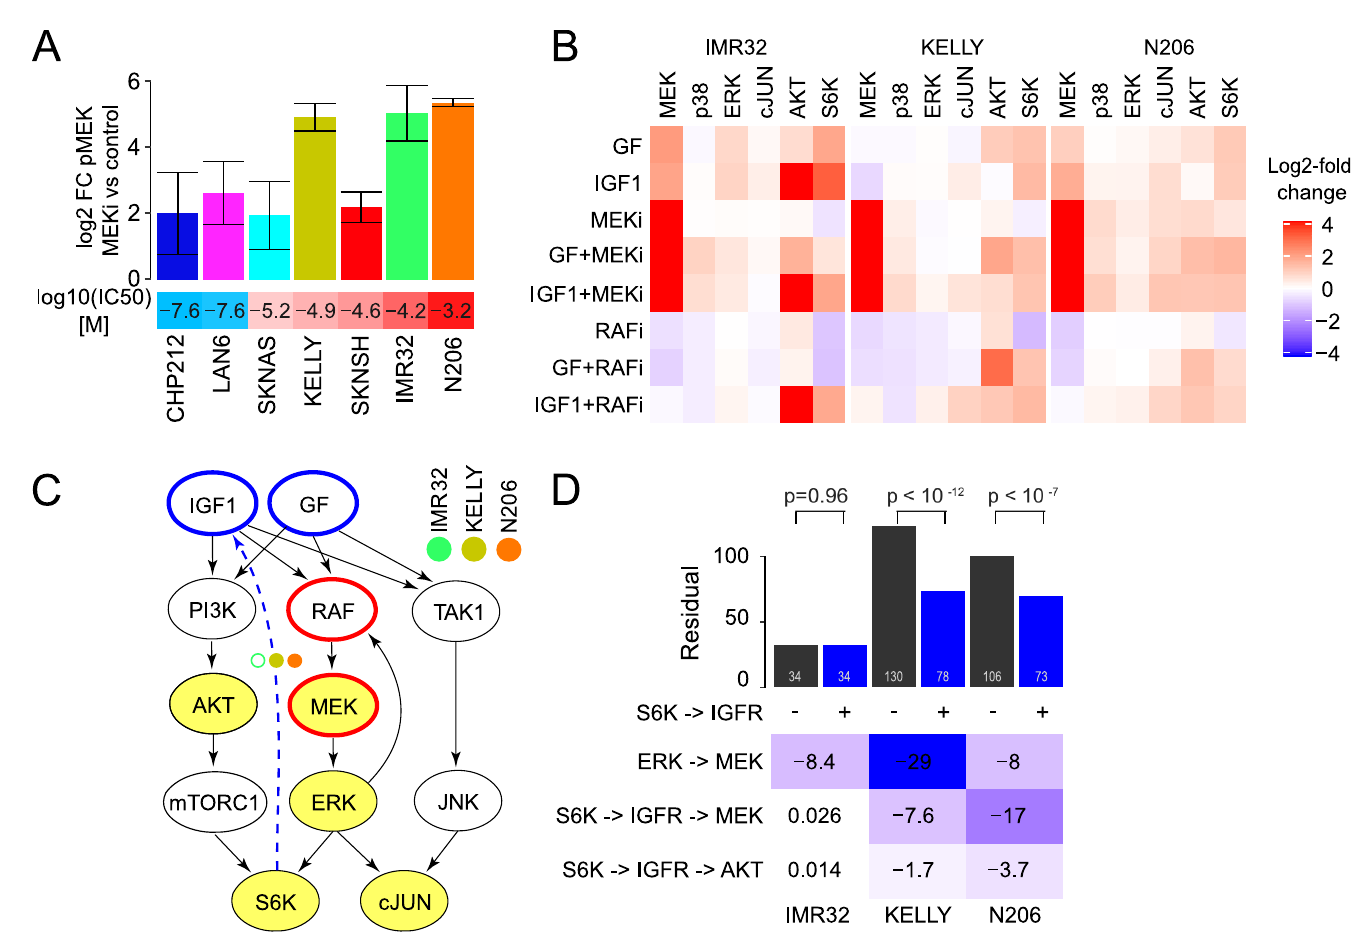
Fig 4. AZD6244 resistant cell lines have strong feedback control of MAPK signalling. A: Mean pMEK log2-fold change relative to control after AZD6244 treatment in 7 neuroblastoma cell lines measured with bead-based ELISAs. Error bars represent 95% confidence interval. B: Measurement of 6 phosphoproteins (columns) after perturbation of N206, IMR32 and KELLY by either EGF (KELLY, N206) or NGF (IMR32) (together referred to as GF), IGF1, or control BSA in combination with Sorafenib (RAFi), AZD6244 (MEKi) or control DMSO. Values are expressed in log2-fold change to BSA+DMSO control. C: Starting model and S6K ! IGF1 receptor extension for the high pMEK responder cell lines. D: (top panel) Model residuals for N206, IMR32 and KELLY models with (black) or without (blue) an S6K ! IGF1 receptor feedback link and corresponding p-value( χ 2 test with df = 1). (bottom panel) Parameter values of the high pMEK responder models including the S6K ! IGF1 receptor